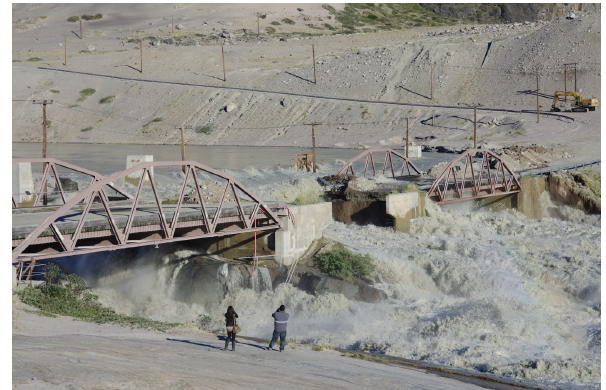
Figure 2. Photograph taken at 18:00 West Greenland Summer Time on 11 July 2012 during the flood with the Watson River Bridge be- ing washed out. Image courtesy of Jens